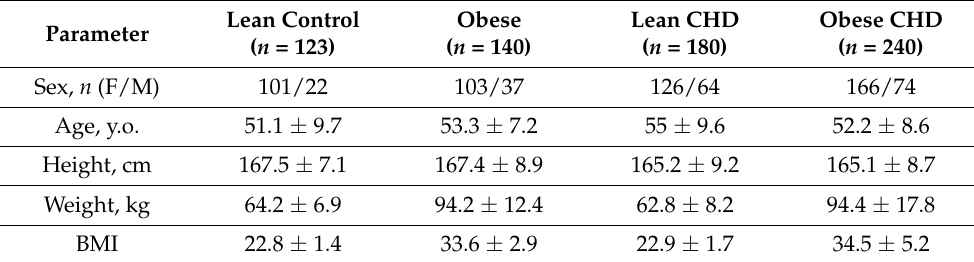
Data are expressed as means and the respective standard deviations; F—female;